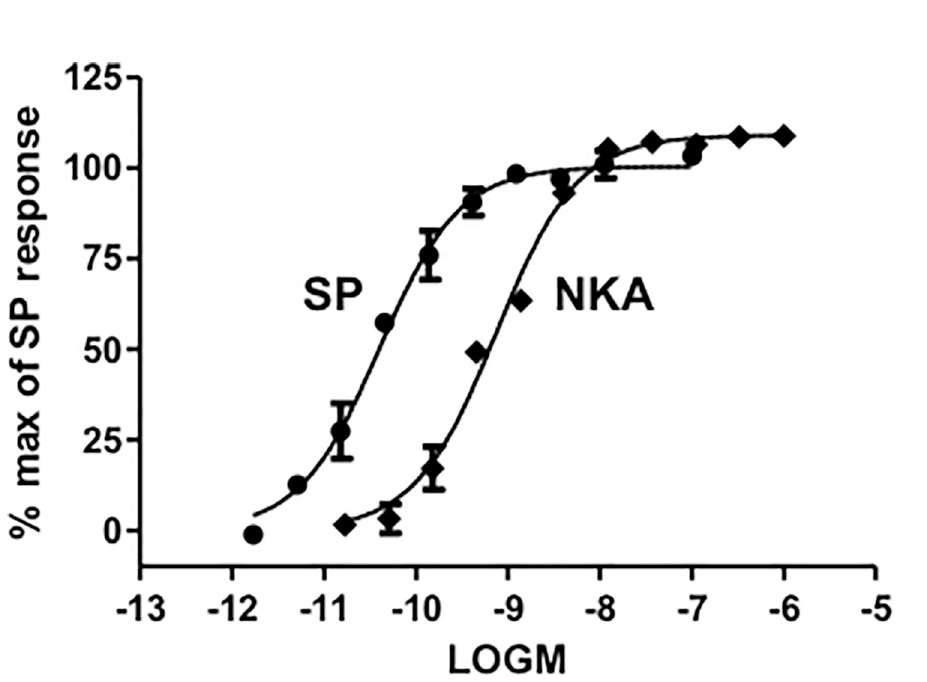
Fig 10. Concentration-response curves for substance P and NKA on intracellular calcium levels using human cloned NK1 receptors. Data are expressed as % of maximal response to substance P (30 nM). Each data point is the mean ± SD of data from an individual experiment performed in